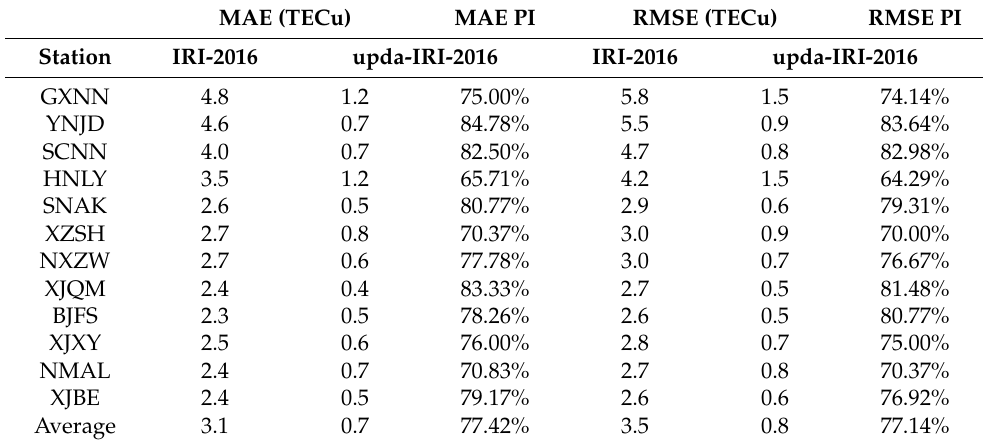
Table 4. Statistical results for the MAEs, RMSEs, and PIs of the TEC estimates for